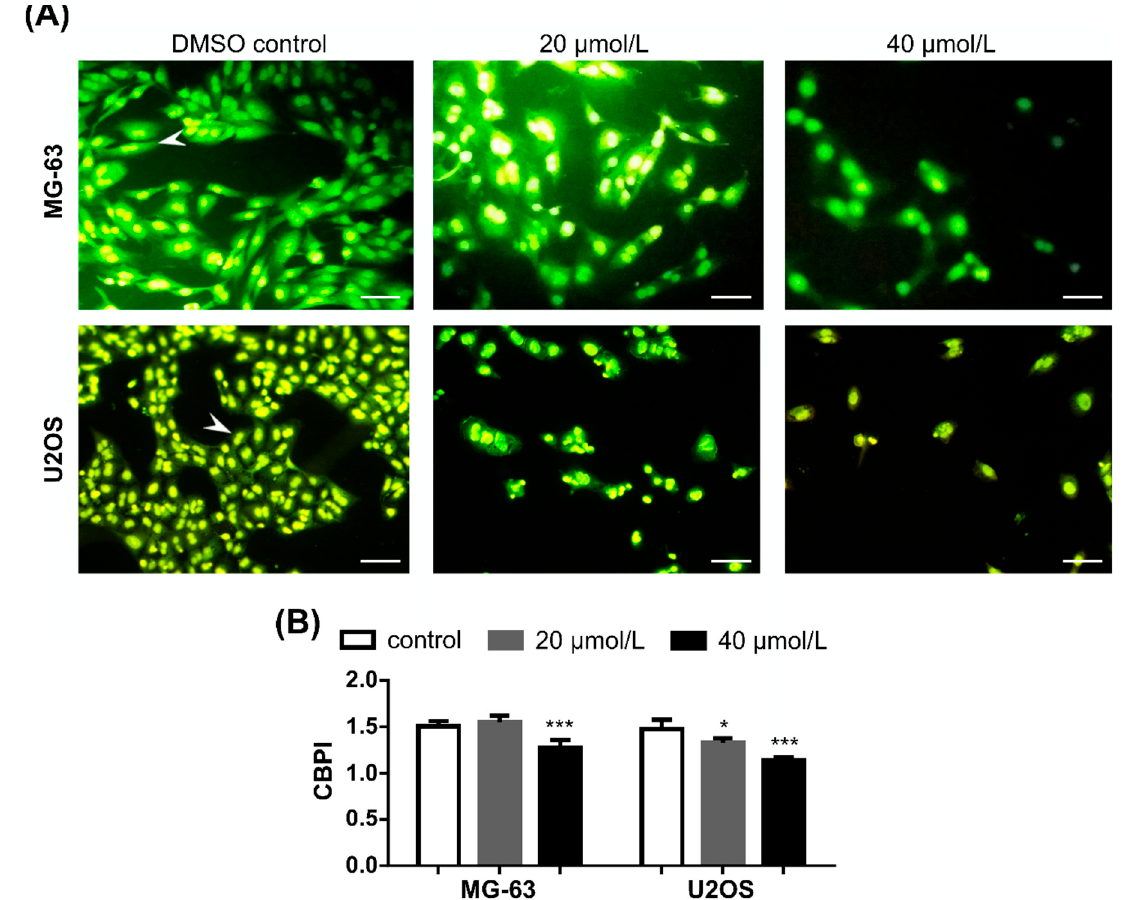
Figure 5. Nuclear division rate. Cells were exposed for 48 h, incubated with cytochalasin B for 40 h, fixed and stained with acridine orange. ( A ) fluorescence microscopy images of exposed cells. Arrow-heads: binucleate proliferating cells; scale bar: 100 μ m. ( B ) cells were discriminated according to the number of nuclei (mononucleate, binucleate or multinucleate), and CBPI values were determined. The data are mean ± SD ( n = 4). Significant differences (asterisks) are shown relative to 0.1% DMSO control; * p < 0.05, *** p < 0.001 (one-way